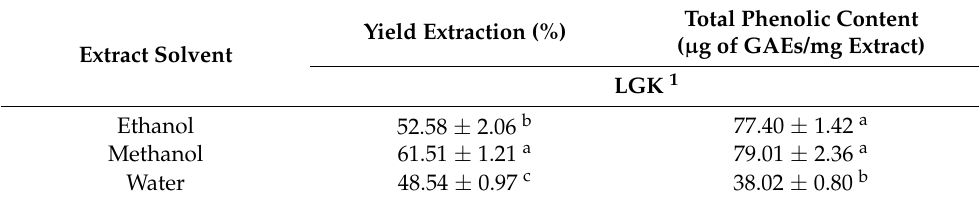
Table 2. The yield of extraction and total phenol content from Godulbaegi kimchi by fermentation duration by diverse